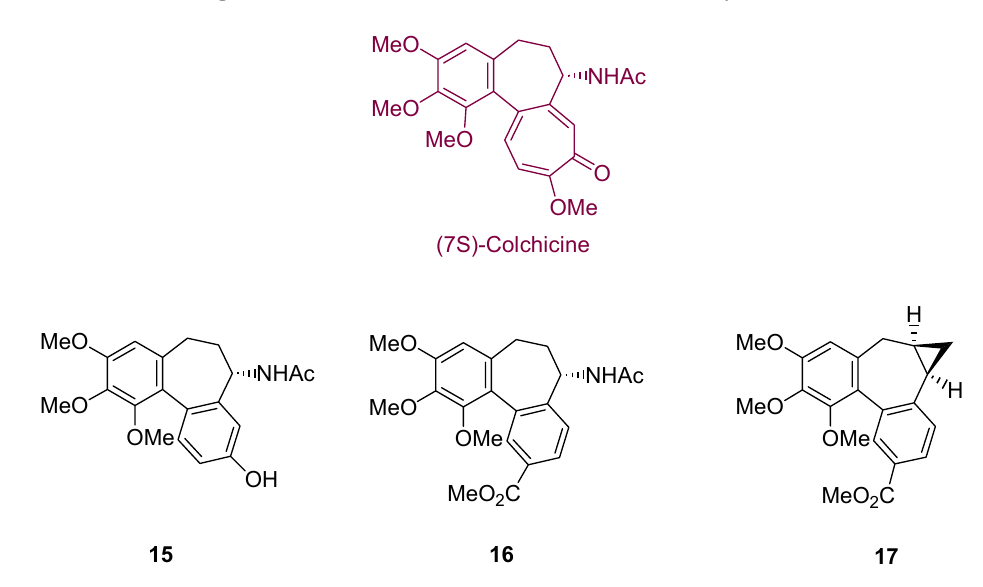
Figure 3. Colchicine and allocolchicinoids